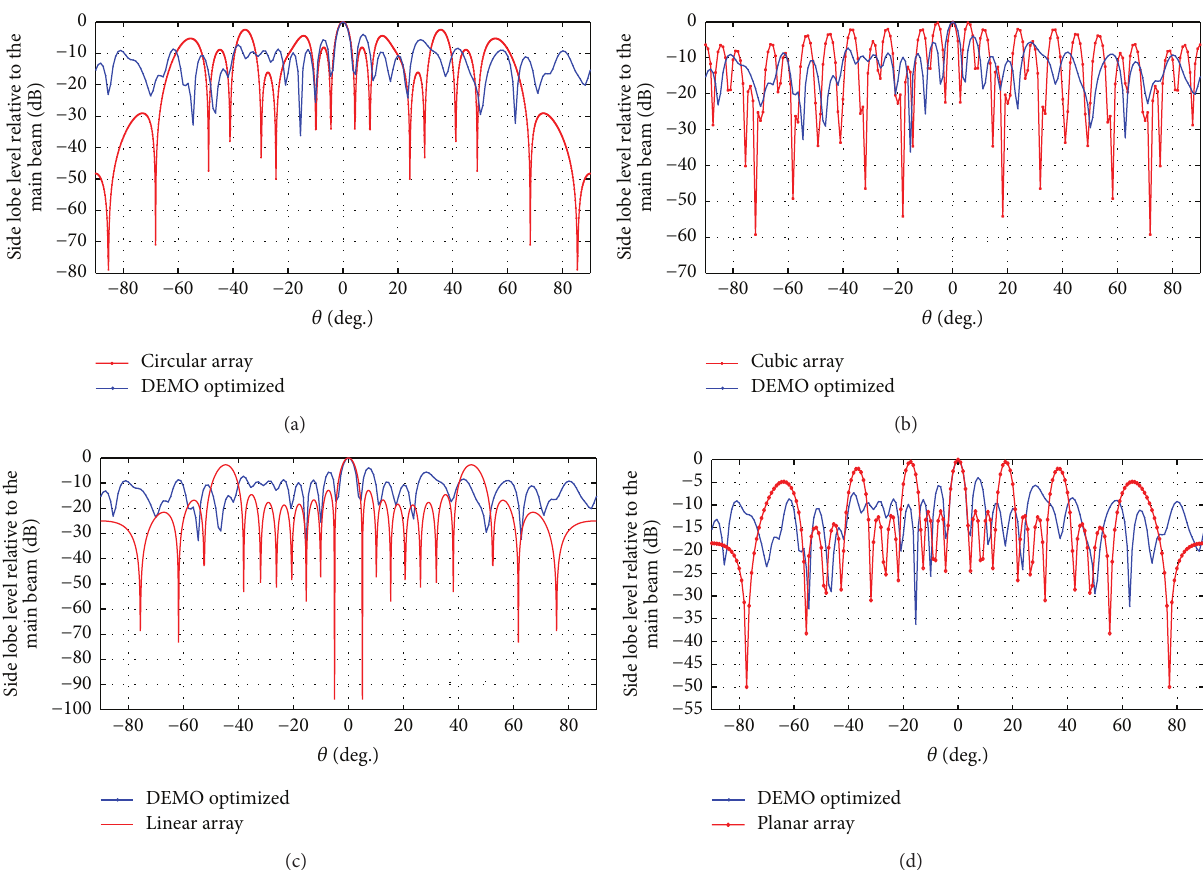
Figure 5: Comparison of the gain or normalized radiation pattern of 3D nonuniform antenna array with respect to the most conventional arrays for UAVs formation flight: (a) 3D array optimized versus uniform circular array, (b) 3D array optimized versus cubic array, (c) 3D array optimized versus uniform linear array, and (d) 3D array optimized versus uniform planar